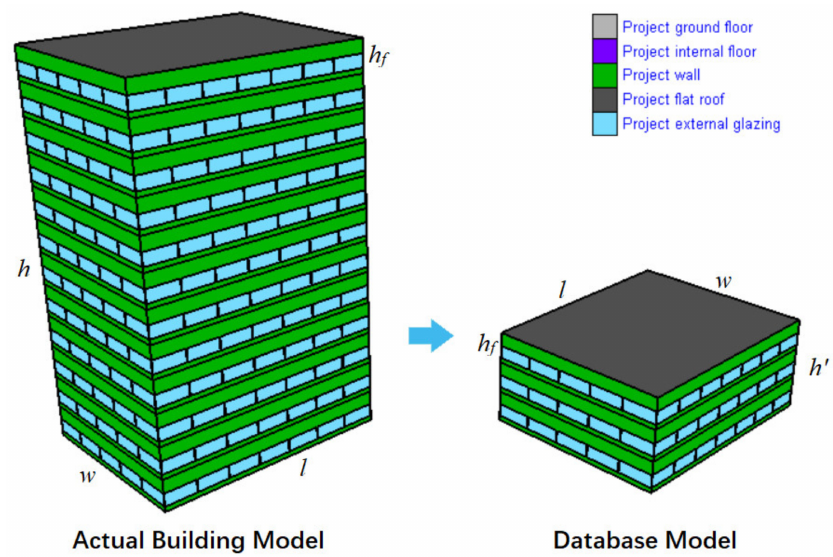
Figure 2. Models of the actual building and in